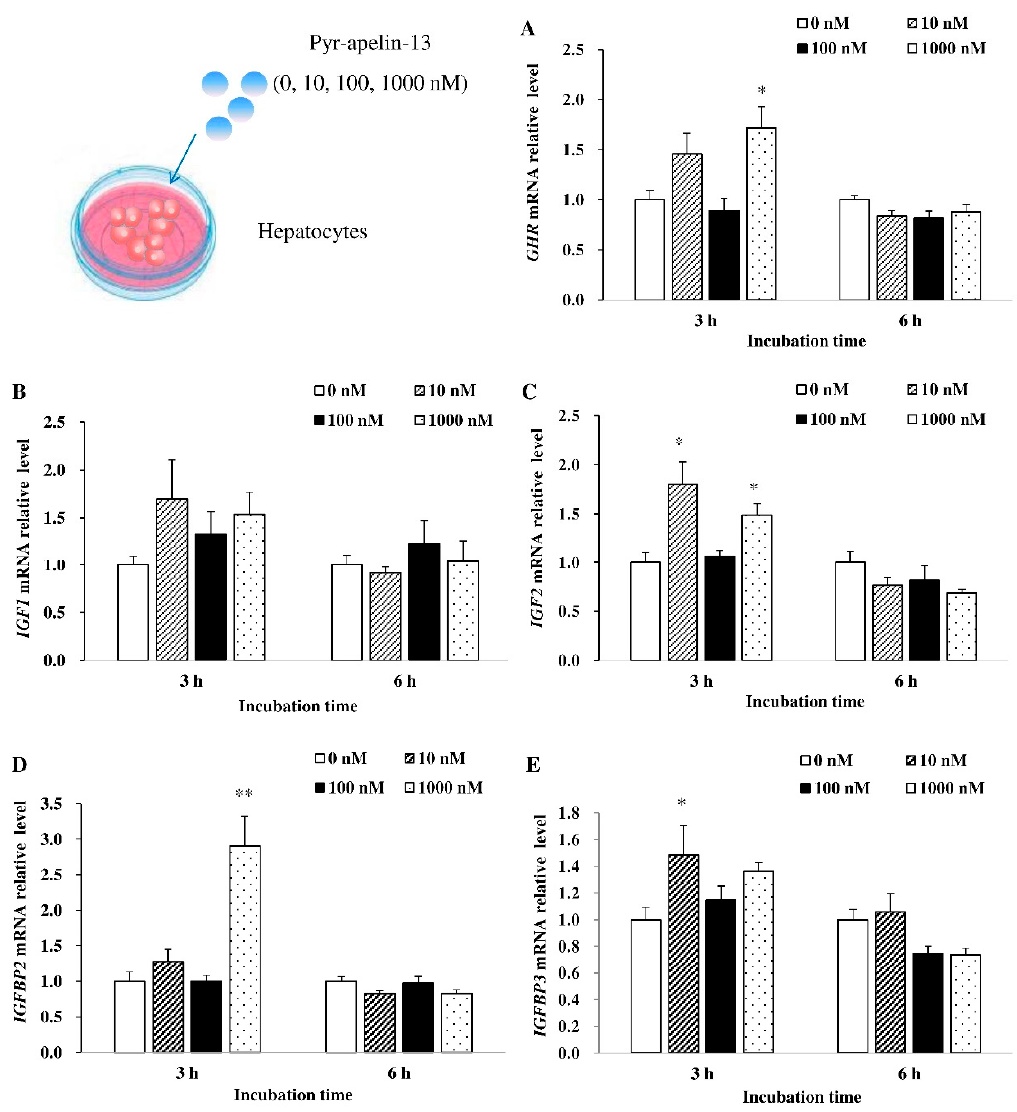
Figure 3. Effects of Pyr-apelin-13 (0, 10, 100, and 1000 nM) on mRNA expressions of growth-related genes in Cyprinus carpio L. primary hepatocytes. GHR ( A ), IGF1 ( B ), IGF2 ( C ), IGFBP2 ( D ), IGFBP3 ( E ). Differences between treatment and control groups at each time point were tested with Duncan’s multiple range test, and are indicated by different asterisks (* p < 0.05, ** p < 0.01). There was no significant difference for PBS administration. The data were given as mean ± SEM. ( n = 6).